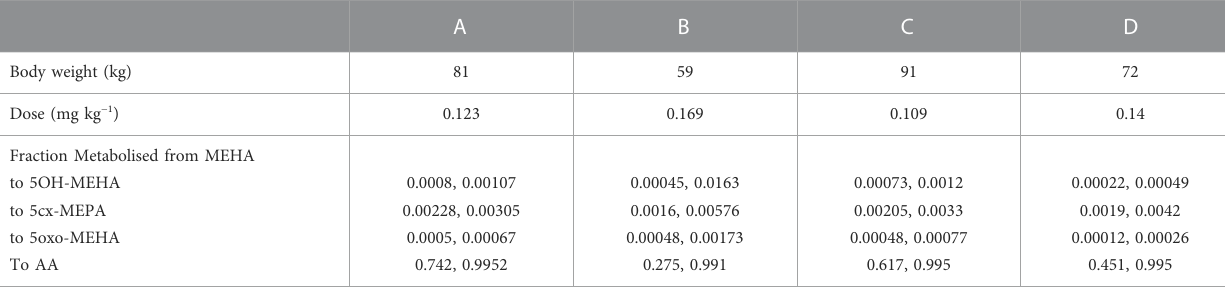
Slowly Perfused